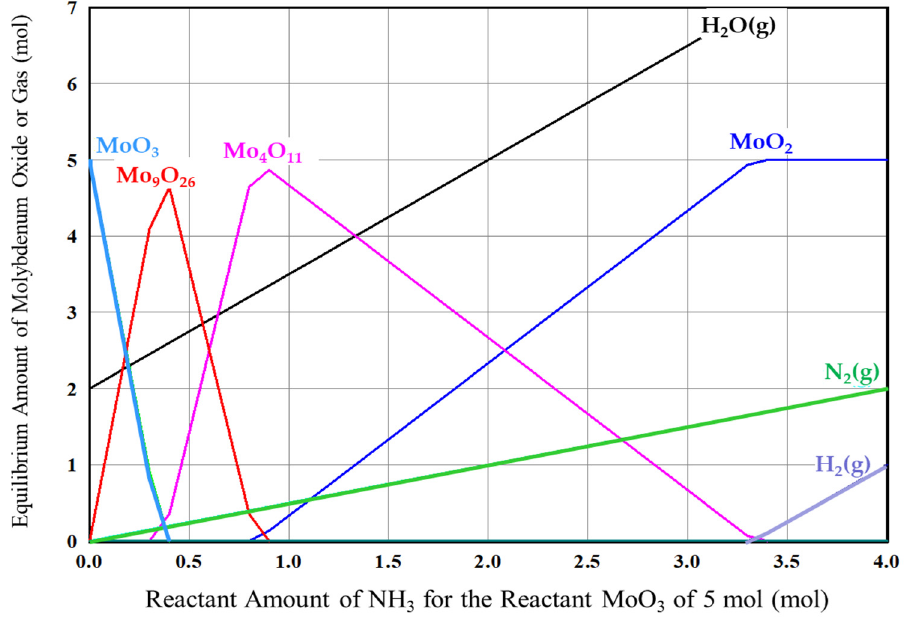
Figure 5. Equilibrium molar amounts when the reaction “5 MoO 3 + (0~4) NH 3 (g) + 2 H 2 O (g)” takes place at 575 °C with a stepwise increase in NH 3 from 0 mol to 4 mol (created using Outokumpu HSC Chemistry 6 software).